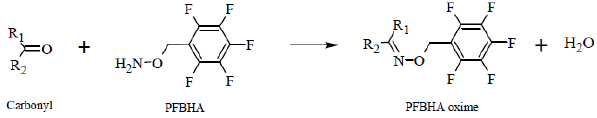
Fig. 1. Derivatisation reaction of carbonyl compounds by the PF- Fig. 1 . Derivatisation reaction of carbonyl compounds by the PFBHA reagent BHA reagent.